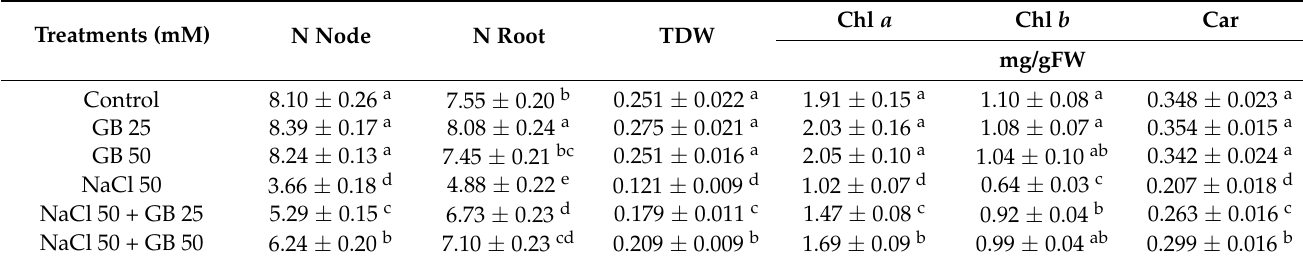
Table 1. Effect of glycine betaine (GB, 0 and 50 mM) on nodule number, root number, total dry weight, and photosynthetic pigments of the stevia plant under NaCl (0, 25, and 50 mM) treatment. Treatments (mM) N Node N